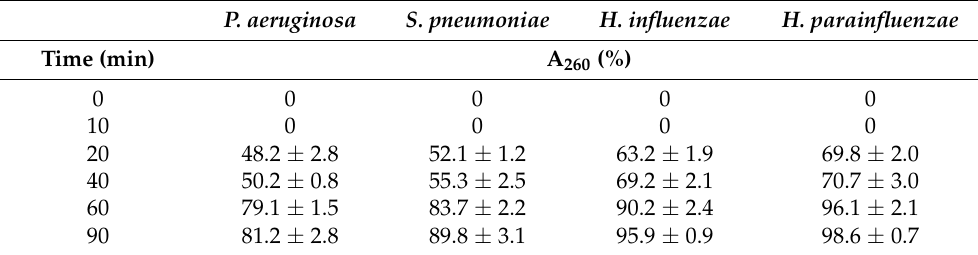
Table 4. The effect of immortelle EO on the release of cellular material, absorbing at 260 nm, from respiratory tract